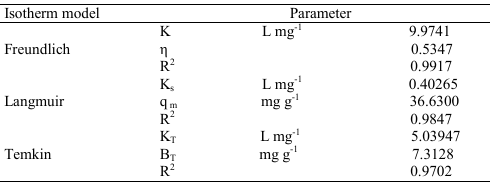
Table 2: Isotherm models for Hg(II) sorption onto nanocomposite Isotherm model